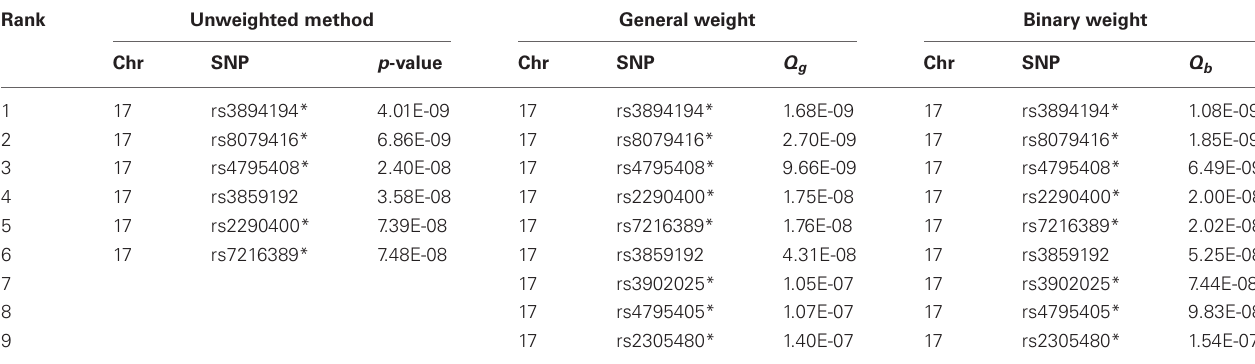
Holm’s method is used with an FWER level of 0.05. *